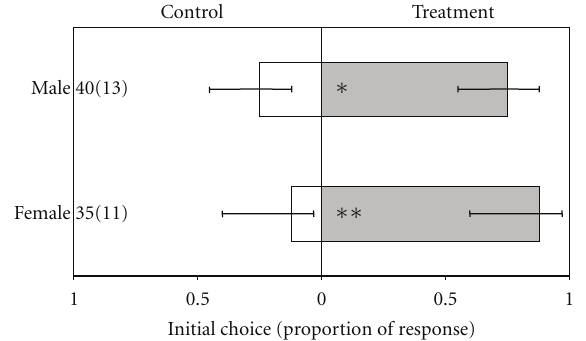
Figure 4: Initial choice (mean ± confidence interval (CI) 95%) of Neomegalotomus parvus males and females to 5 uL of a solution containing the synthetic authentic standards found in females extracts (hexyl butanoate (0.005mg/mL), 4-( S )-methylhexyl- butanoate (0.0005 mg/mL), hexyl pentanoate (0.00075 mg/mL), 4-( S )-methylhexyl-pentanoate (0.0002 mg/mL), hexyl hexanoate (0.00075 mg/mL). Analyses of initial choices were carried out by logistic regression and χ 2 Wald test. ∗ indicates P < 0 . 05 and ∗∗ indicates P < 0 . 01. Numbers at left indicate total number of insects tested and numbers in brackets indicate the number of insects that did not make a choice after 5